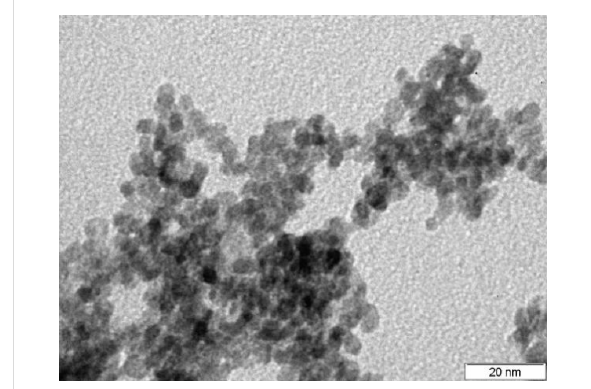
Figure 2: TEM image of blank tin dioxide nanopowder after annealing.